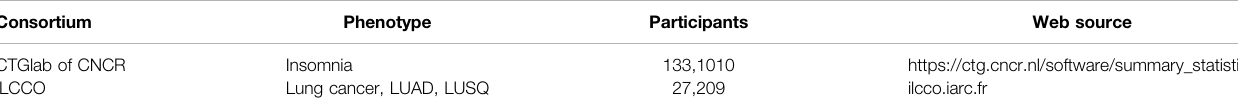
TABLE 1 | Genome-wide Association Study Utilized in this MR Analysis. Consortium